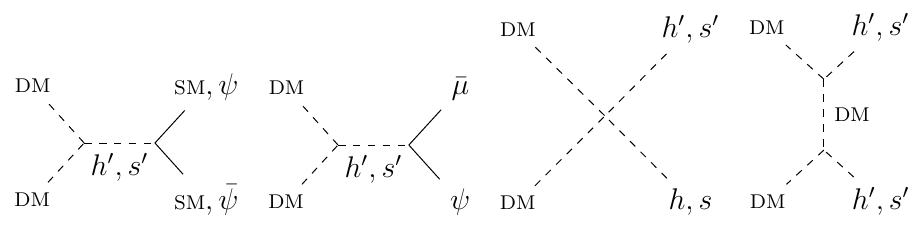
Figure 1 . Shown are tree-level Feynman diagrams for dark matter annihilation Figure 1: Shown are tree-level Feynman diagrams for dark matter annihilation processes.